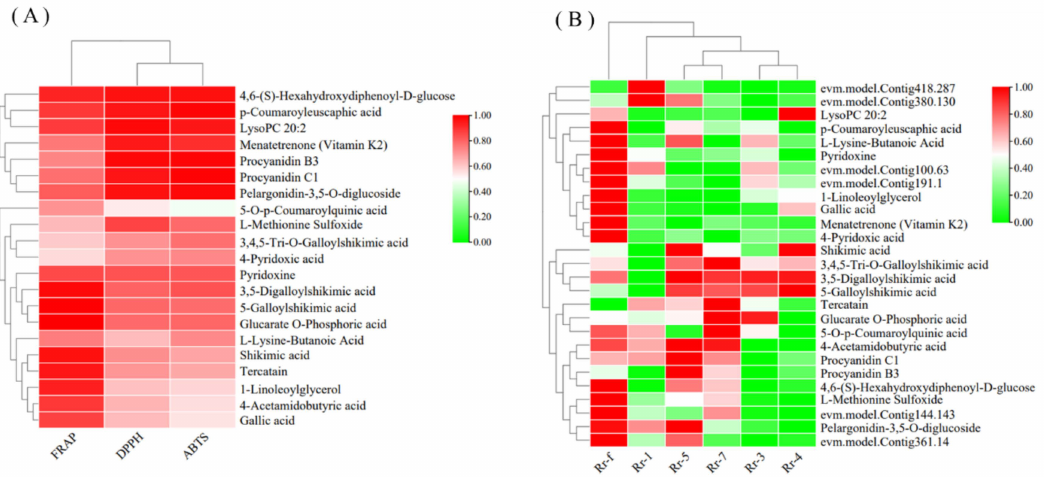
Figure 9. Heatmap of relevant indicators. ( A ) Correlation coefficient between key metabolites and antioxidant capacity. High correlation corresponds to red, and low correlation corresponds to green. When the correlation coefficient is ≥ 0.7, it is significant at the level of 0.05; when the correlation coefficient ≥ 0.8, it is significant at the level of 0.01. ( B ) Heatmap of the key metabolites and RrMYBs . Different colors represent the values for standardized treatments of relative content, ranging from low (green) to high